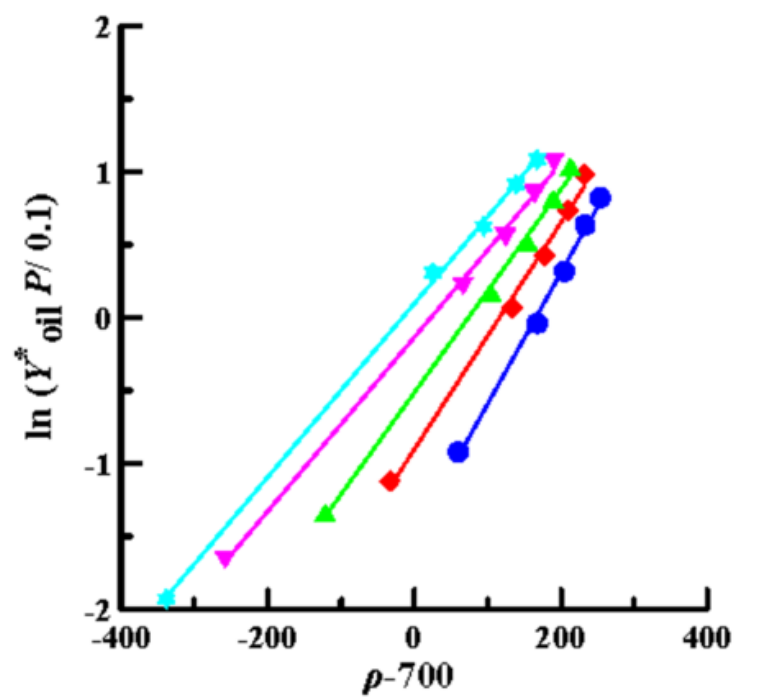
Figure 5. Plots of ln ( Y* o il ) versus ρ using the K–J model for oil extraction from P. frutescens leaves at various temperatures and pressures of 10.5–33.0 MPa. ( • :32 ◦ C; (cid:117) : 38 ◦ C; (cid:78) : 43 ◦ C; (cid:72) : 49 ◦ C; (cid:70) : 55 ◦ C).